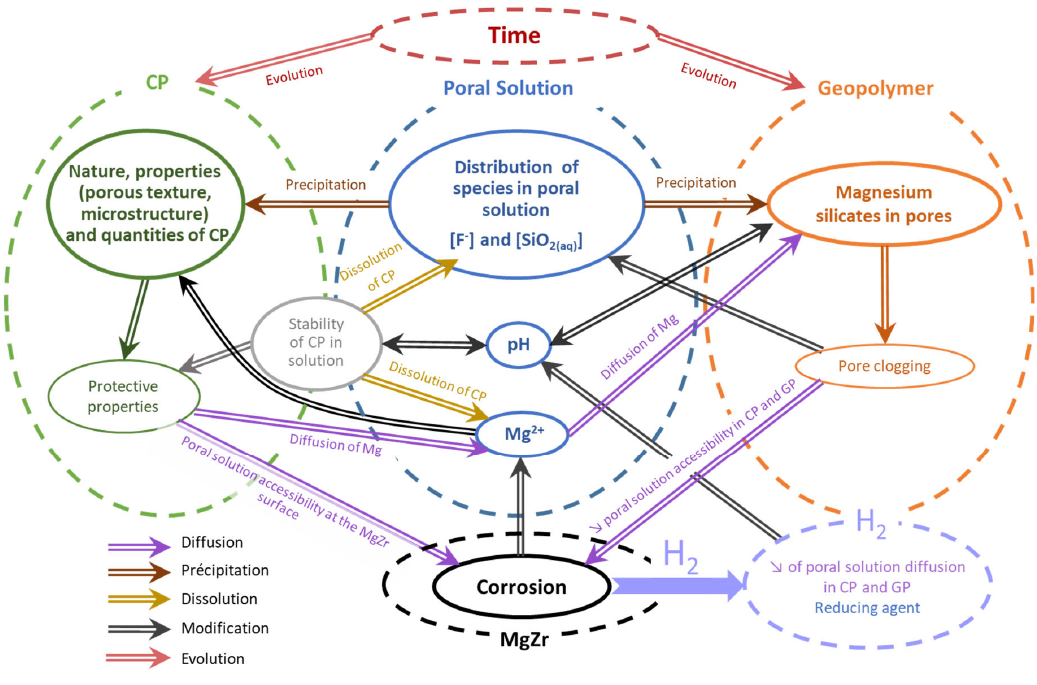
Figure 12. Proposition of interconnected processes involving during the corrosion of MgZr within geopolymers.